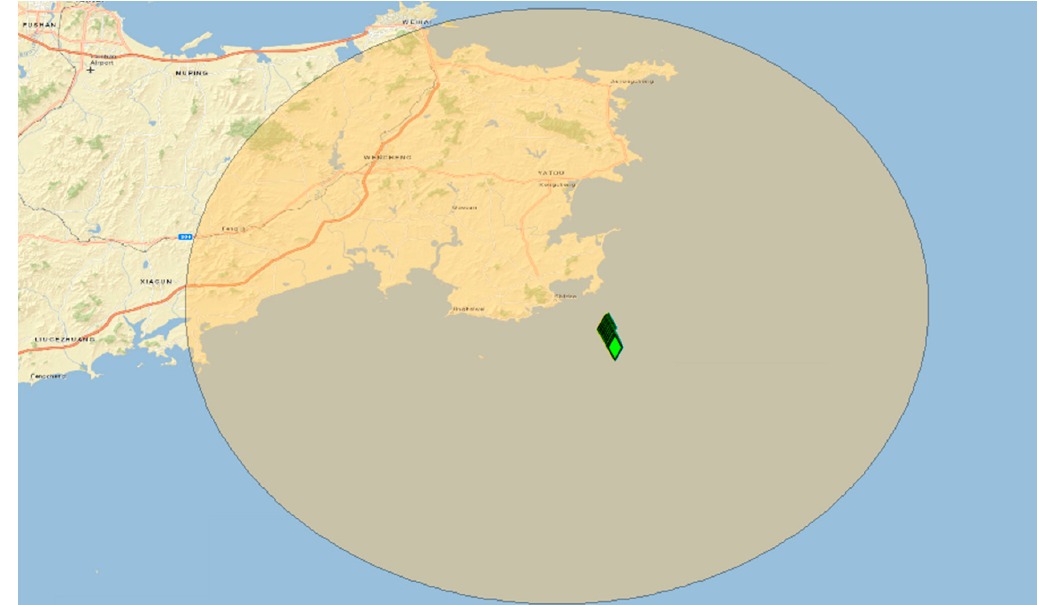
Figure 10. Fusion of data is performed by overlaying historical vessel automated identification system (AIS) data from time of incident over top of spatial cluster which was generated using the SCOOP methodology. AIS broadcasts from the Tian Xiang 69 vessel are represented by small diamonds and shown located directly within the generated cluster. Its initial isolated AIS broadcast is located 58 km to the closest cluster outer edge.